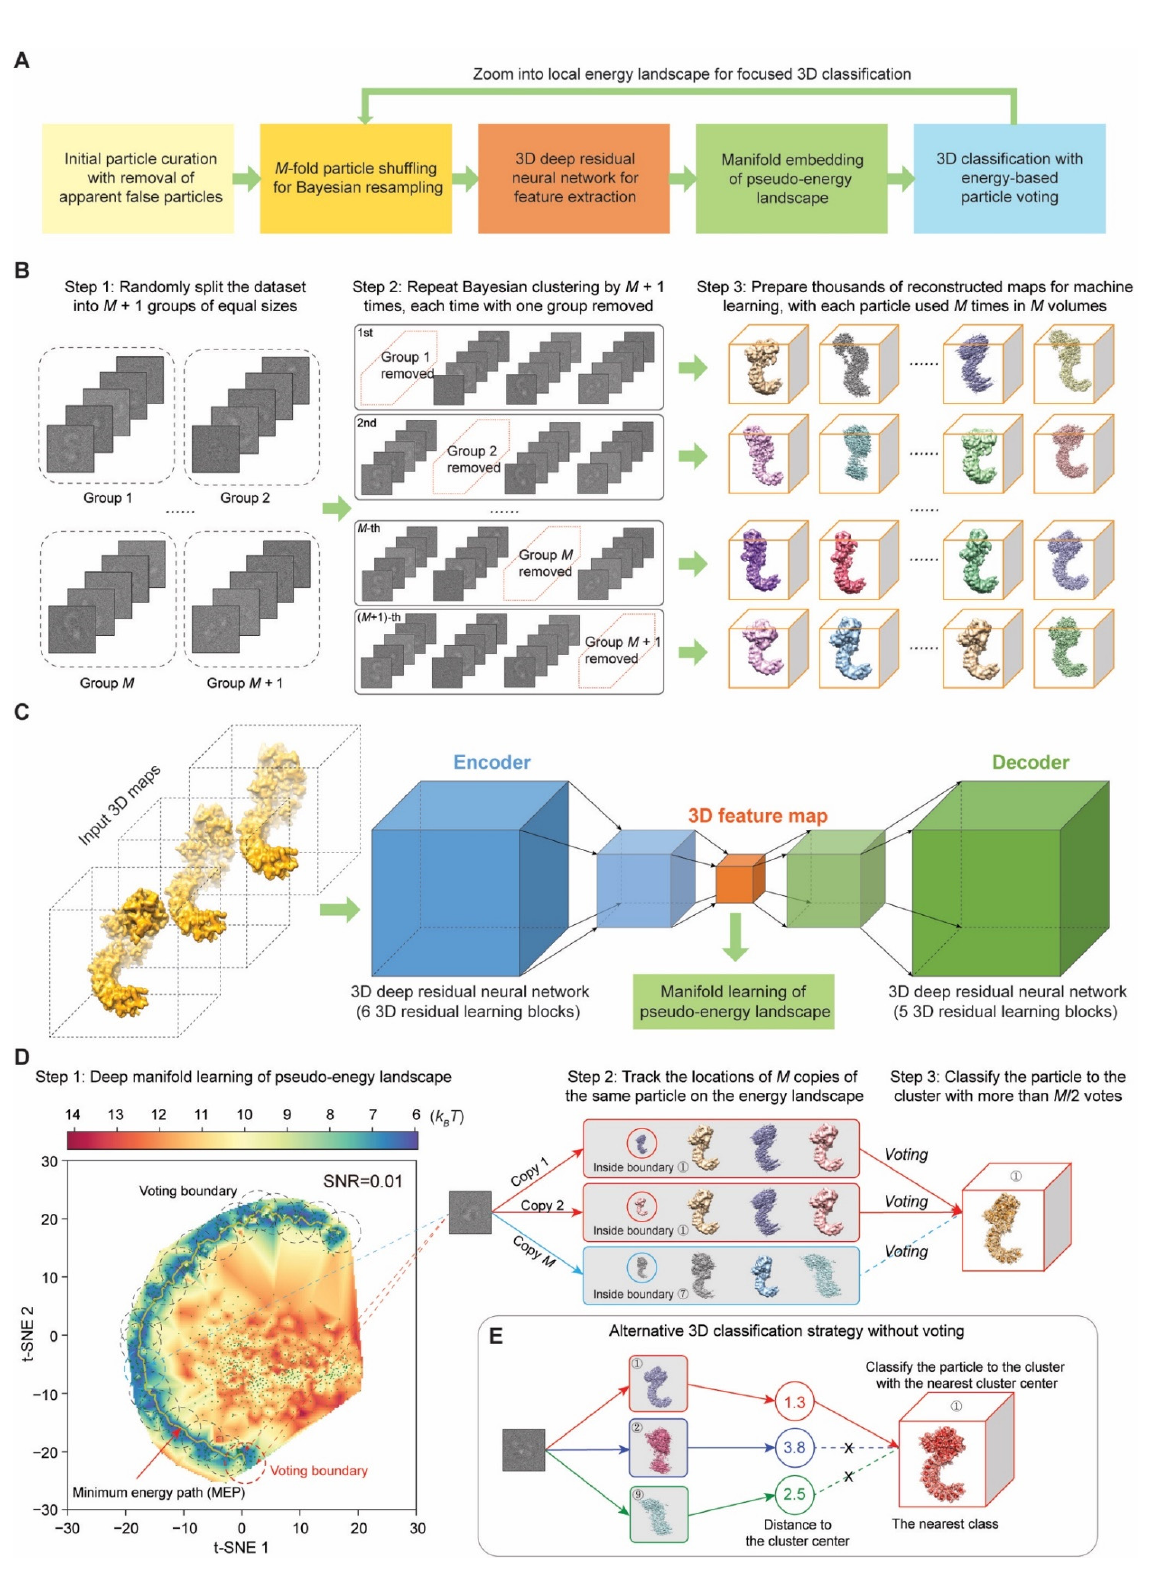
Figure 1. Algorithmic framework of AlphaCryo4D for 4D cryo-EM reconstruction. ( A ) Schematic showing the major conceptual steps of single-particle cryo-EM data processing in AlphaCryo4D. ( B ) Schematic showing the method of M -fold particle shuffling for resampling of 3D volumes. In step 1, all particles are split randomly into M + 1 groups equally. Then step 2 carries out the Bayesian clustering for reconstructions of 3D density maps within each of the M + 1 particle sets that are shuffled via the ‘removing-one-group’ approach. After these two steps, thousands of 3D